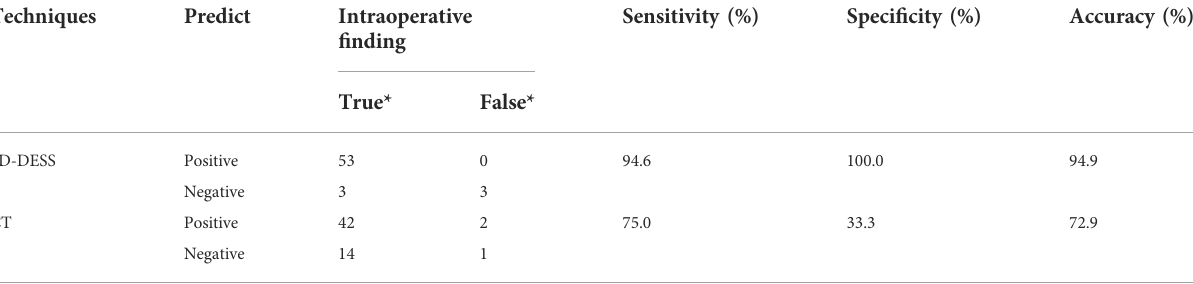
TABLE 3 Comparison of diagnostic ef fi ciency of 3D-DESS and CT fore* Data were the numbers of patients.